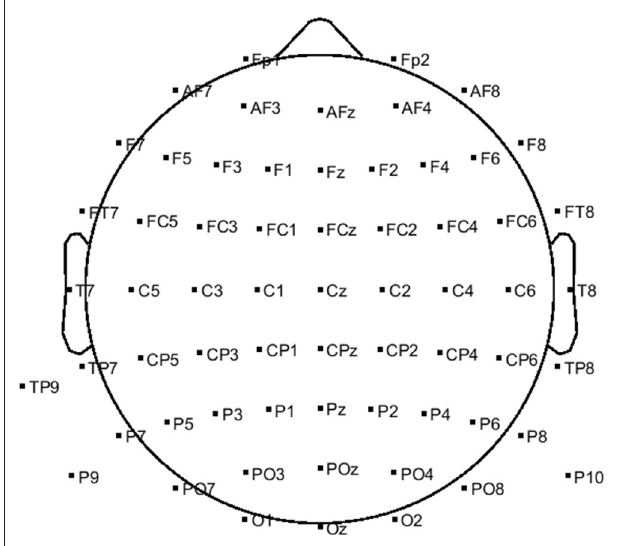
FIGURE 1 | Positions of 63 active EEG electrodes on the scalp.